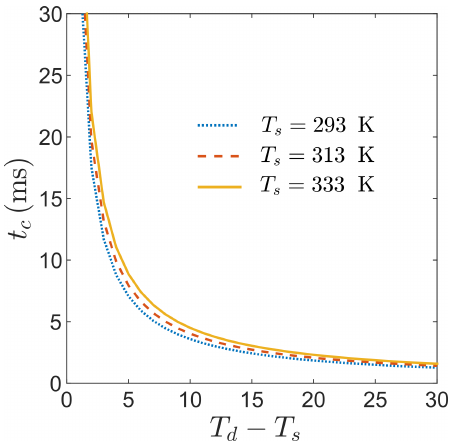
Figure 6. The time t c required for condensate to fill superhydrophobic microtexture is estimated and plotted as a function of temperature difference T d − T s for three representative surface temperatures (curves). These values are calculated using Equation (2) assuming the properties of a water drop on a microtexture with a characteristic lengthscale of L = 10 µ